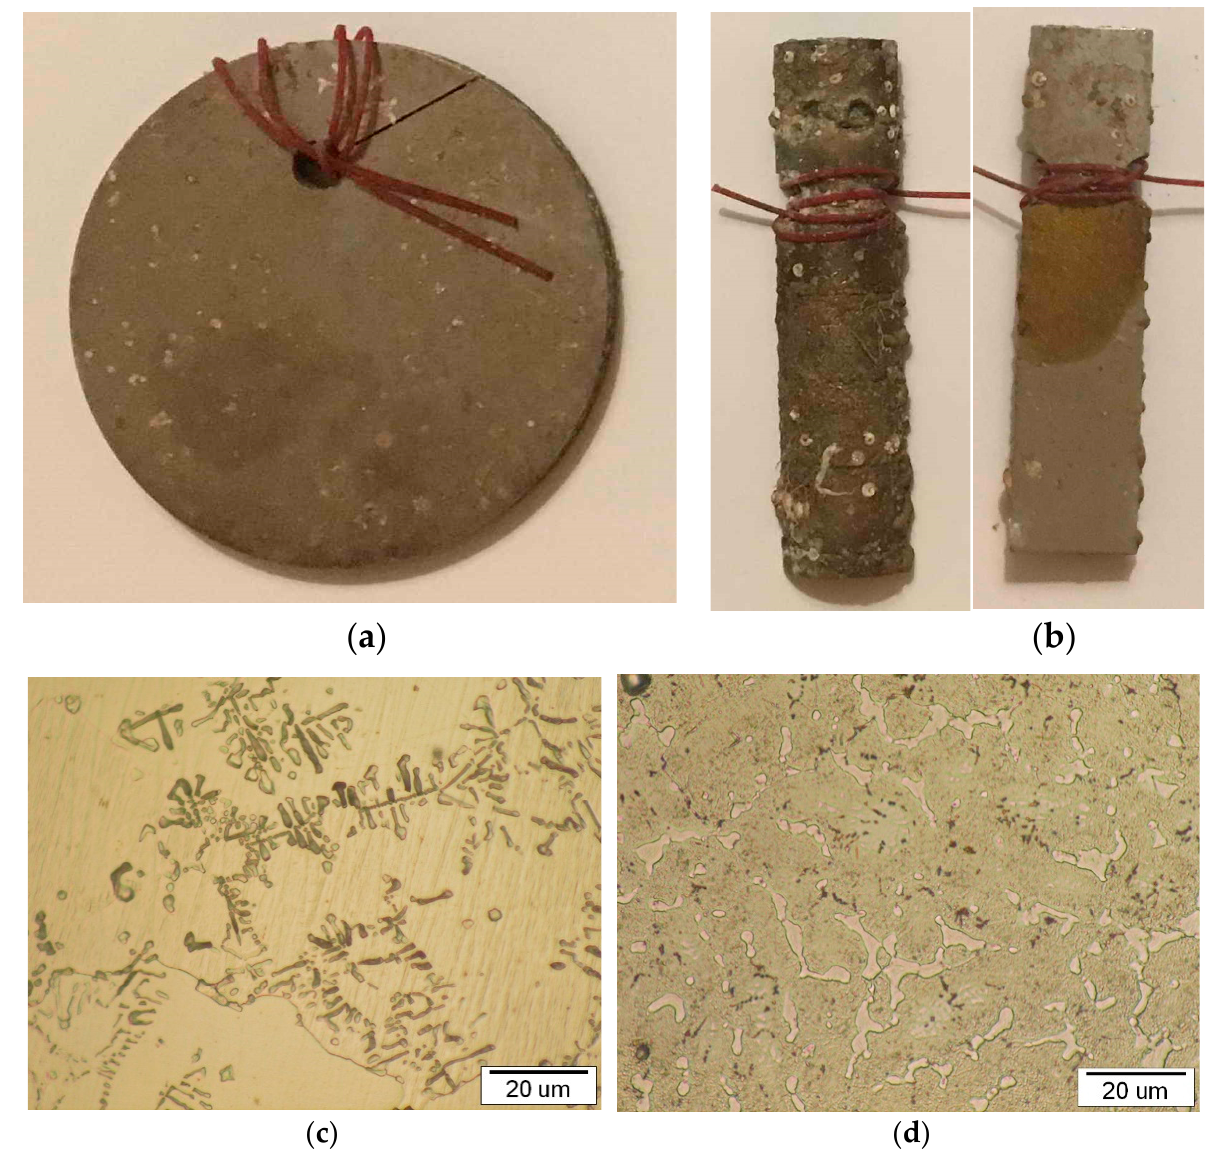
Figure 1. A sample of the NiTi1 alloy disk ( a ), NiTi2 rod alloy ( b ), the optical microstructure of the NiTi1 alloy ( c ), and NiTi2 alloy ( d ).